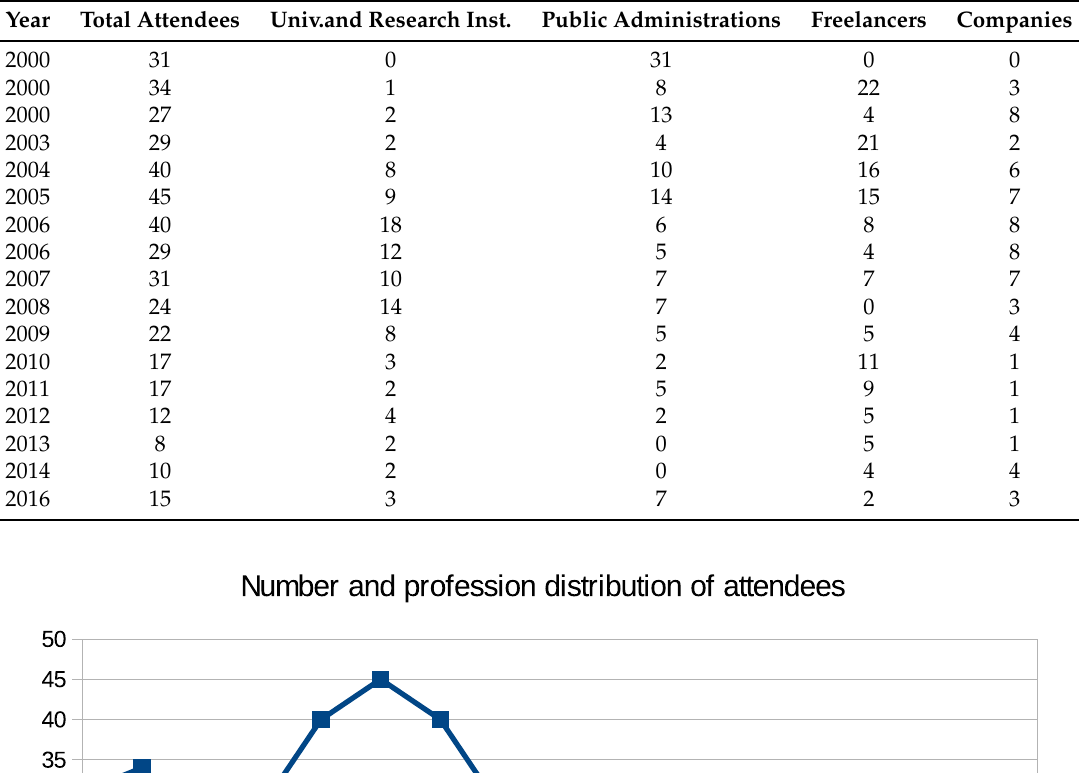
Table 1. Participants of the courses designed for professionals, total attendees and attendees divided into four classes according to their occupation: university and research institutes, public administrations, freelance/technical offices and companies. Note that three different courses were held in the year 2000.